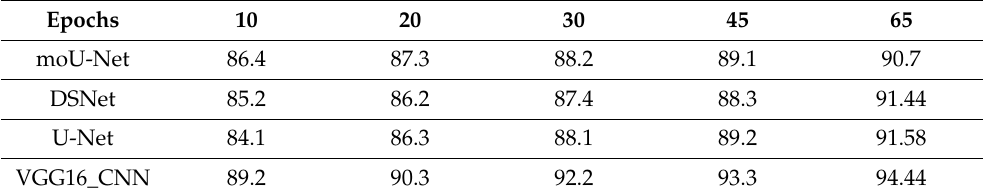
Table 4. Comparison of recall over various epochs between existing techniques and proposed meth- odology.